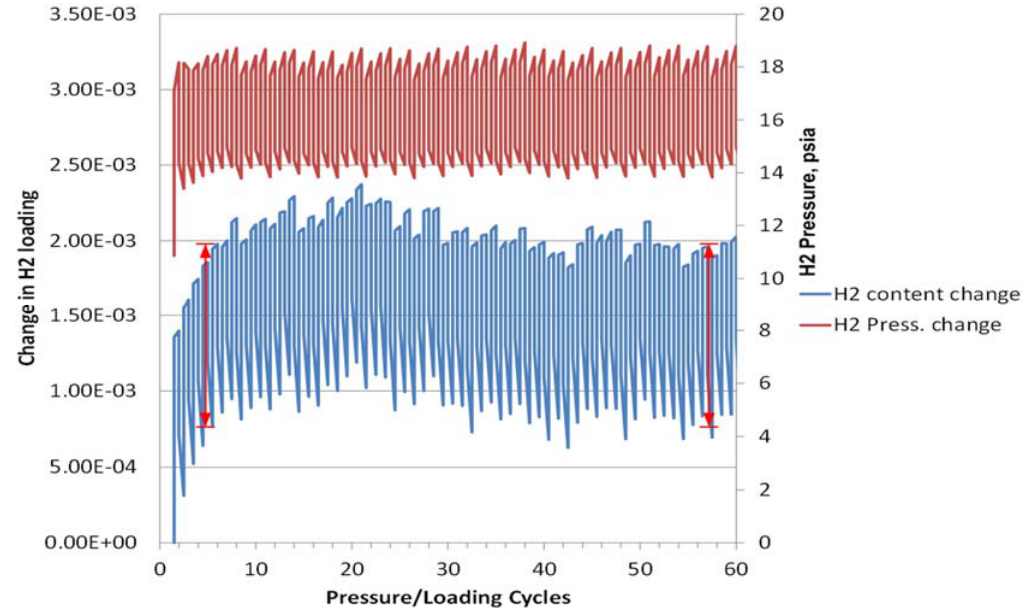
Figure 4. Life cycle of 2.55-gram Ti-sponge at 650 °C showing 60 cycles over 70 h (60 absorption/60 desorption) without a capacity drop in hydrogen pressure